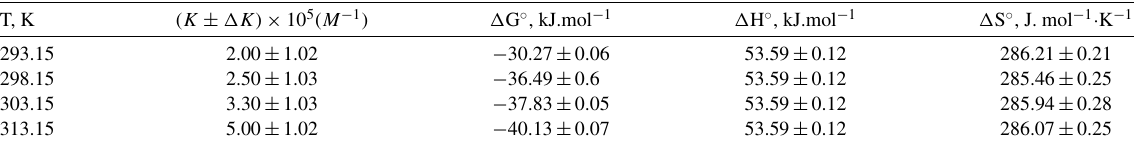
Calculated thermodynamic parameters for binding of Zn(tmtppa) to DNA in 5mM phosphate buffer, pH 7.2, at 25 ◦